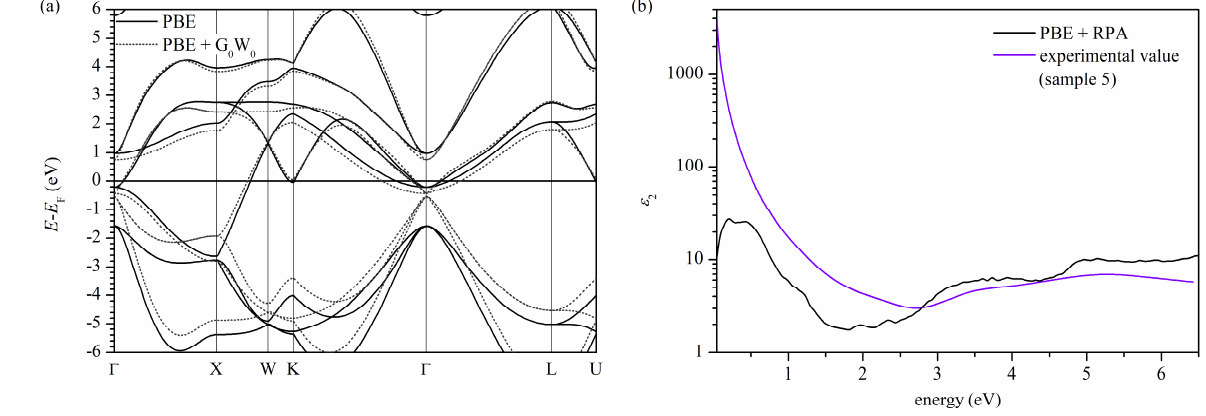
Figure 3. ( a ) Band structure and ( b ) imaginary part of the dielectric function.